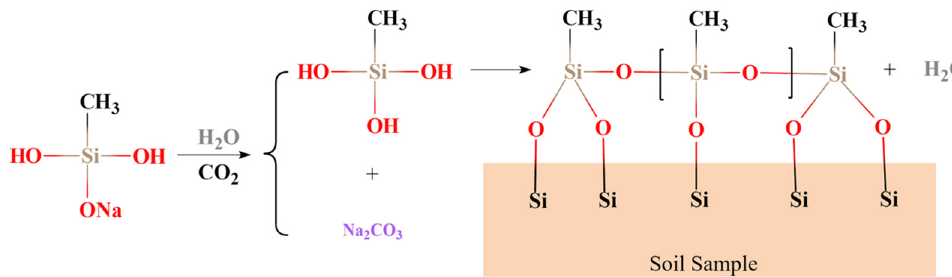
Figure 6. Reaction process of SMS with H 2 O and CO 2 and bond diagram with soil.